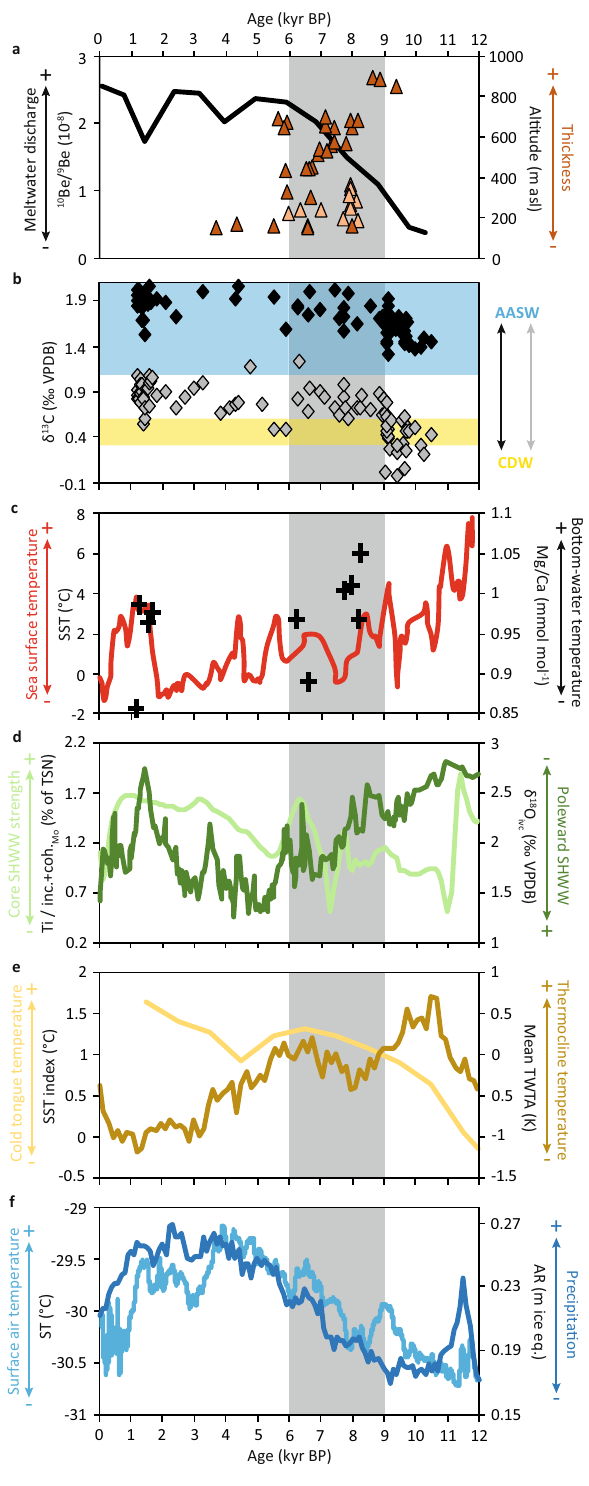
Mid-Holocene between ~5.9 and ~4 kyr BP as inferred by the presence of the CDW-associated benthic foraminifer B.